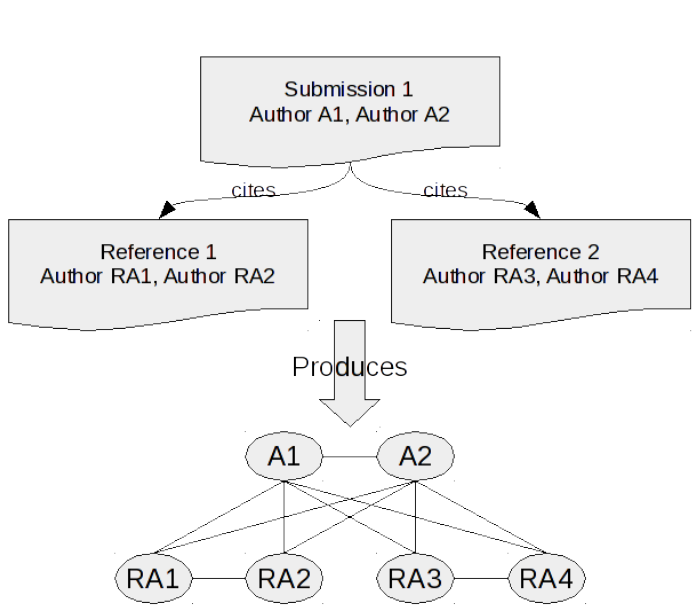
Figure 1 . The citation networks – connecting the authors of a research proposal (A1 and A2) with the authors of two cited references (RA1, RA2, RA2 and